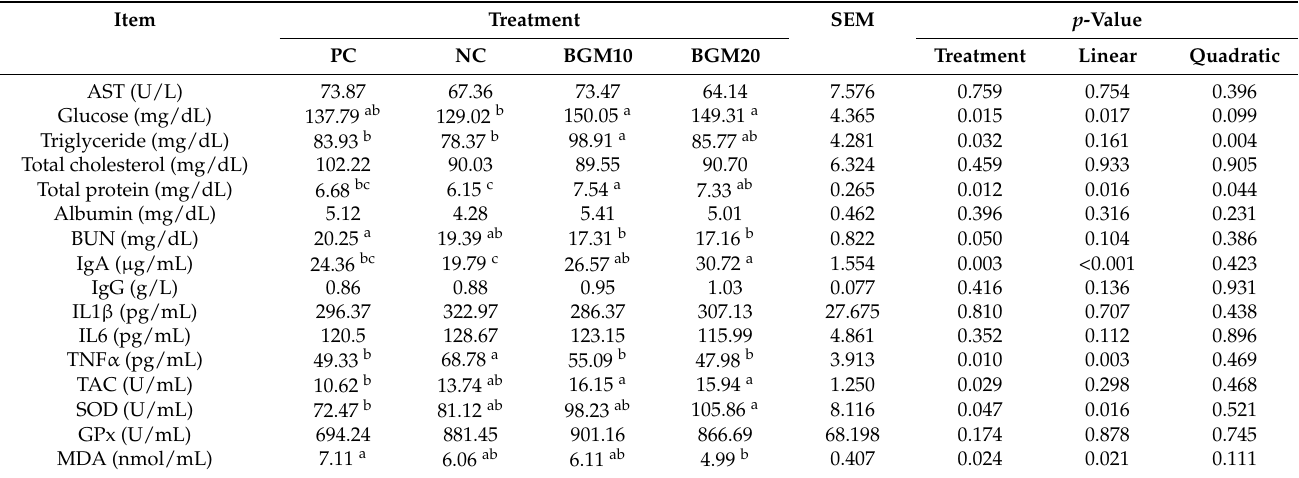
Table 4. Effect of dietary BGM with multienzyme addition on blood profiles, immunity, and oxidative status in weaning pigs 1,2 .